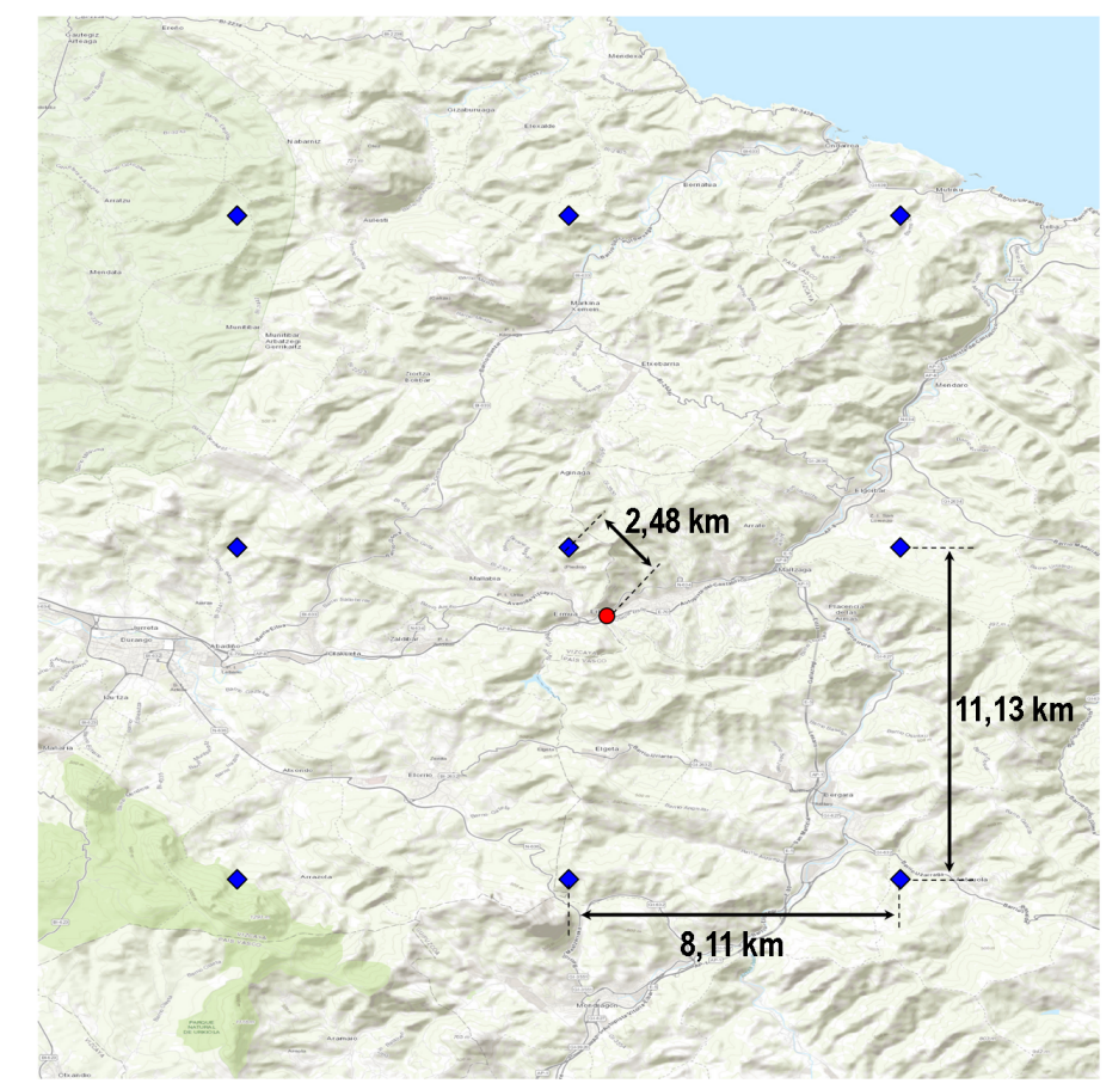
Figure 10. Nearest ERA5 grid points (blue) around the study point